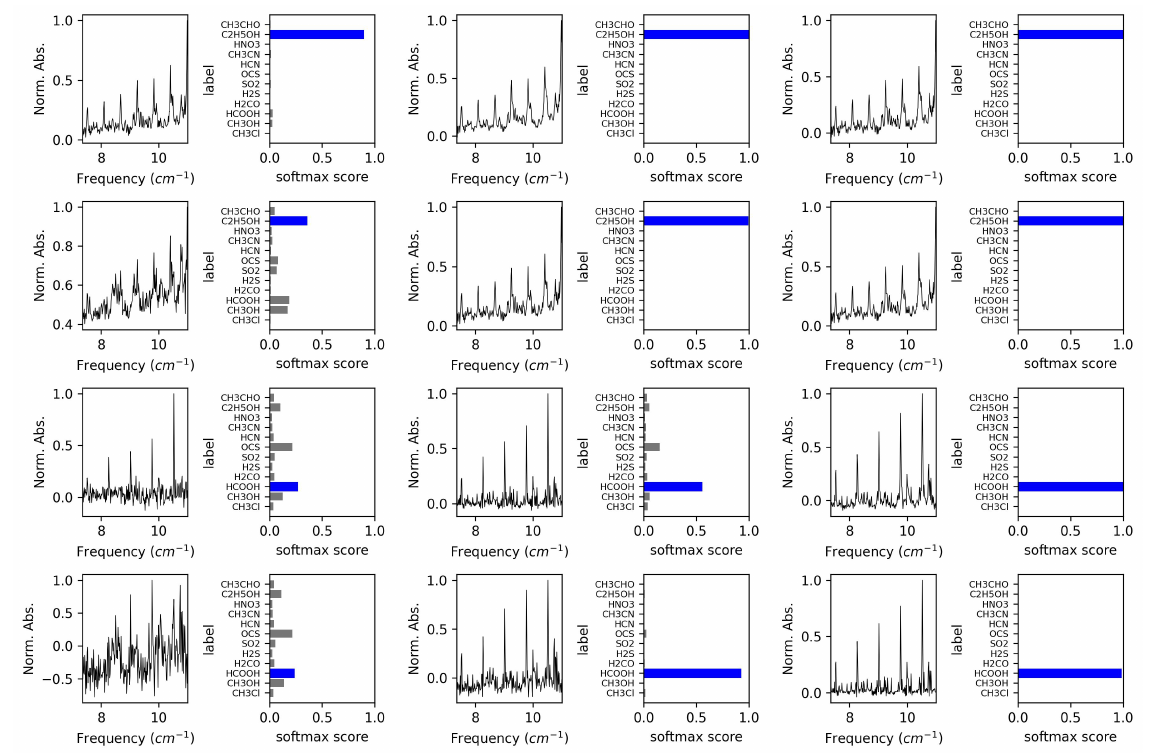
Figure 12. VOC-Net classification of experimental spectra (1–12). The corresponding softmax scores for each classification are given with each spectra.